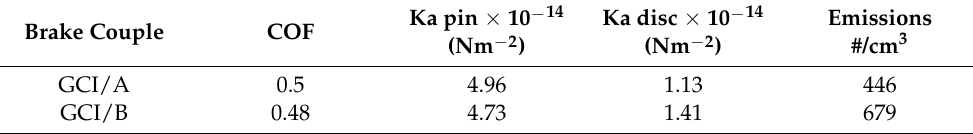
Table 6. Wear test results of friction materials A and B against uncoated